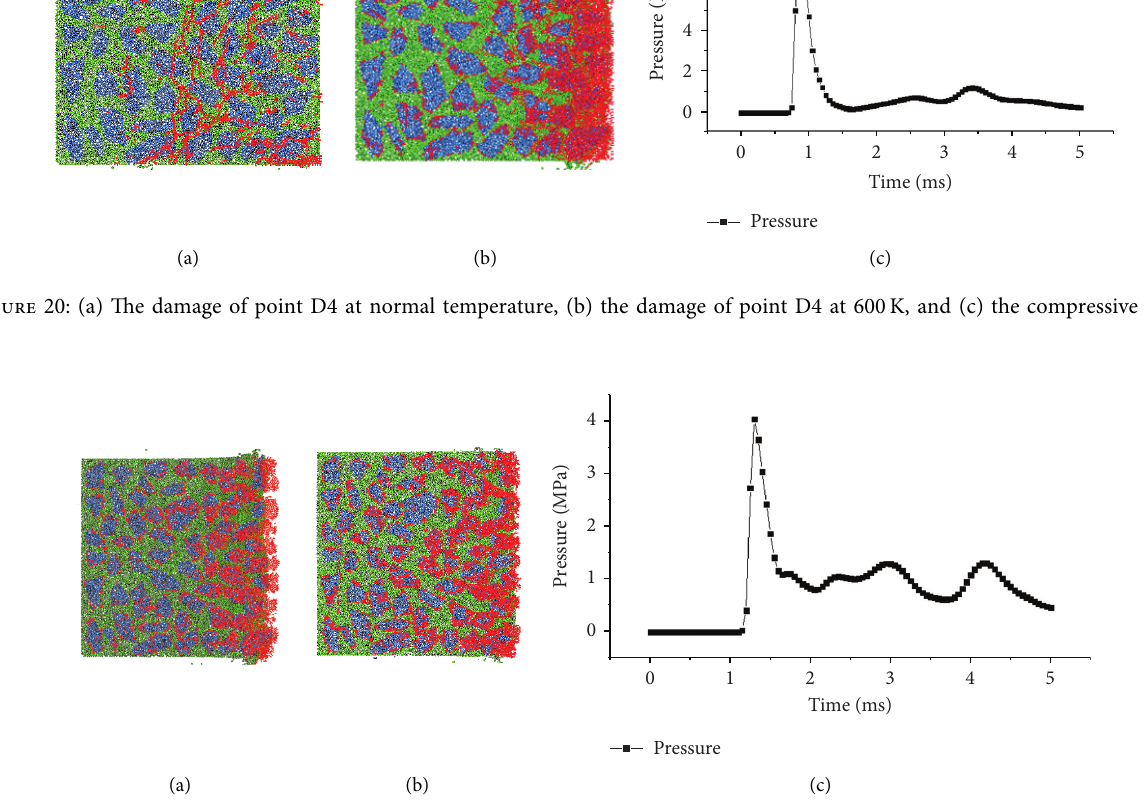
Figure 21: (a) The damage of point E0 at normal temperature, (b) the damage of point E0 at 400K, and (c) the compressive